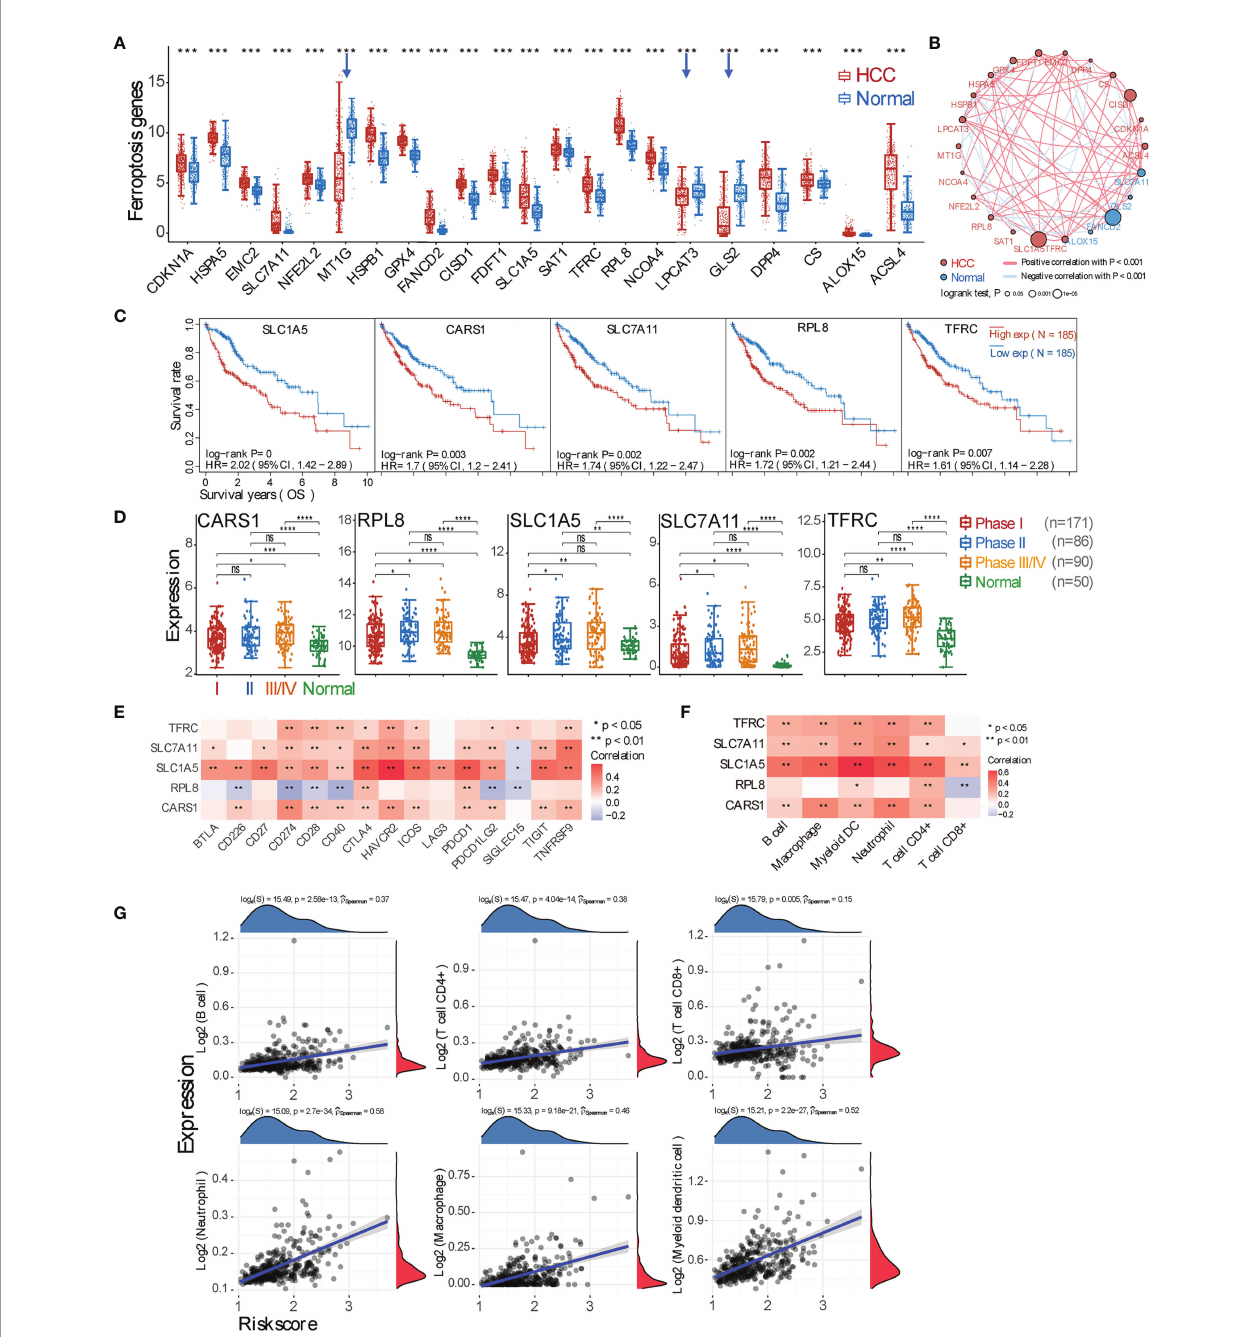
FIGURE 3 | Marker gene expression of ferroptosis and its correlation with tumor microenvironment (TME) immune pro fi le. (A) Expression comparison of ferroptosis marker genes between hepatocellular carcinoma (HCC) and normal tissues. The downregulated genes in HCC tissues are highlighted by blue arrows. (B) Gene relationship. Each circle represents a gene: the red one means positive, while the blue one represents negative correlation. The different sizes of the circle mean the different log-rank p-value. (C) Representative overall survival curves of 5 genes (SLC1A5, CARS1, SLC7A11, RPL8, and TFRC) that are negatively and signi fi cantly correlated with prognosis (p < 0.01). (D) Expression of these 5 marker genes in tumor tissues from pTNM stage I, II, or III – IV patients. (E) Correlation analysis between 5 marker genes and checkpoint molecules. (F) Correlation between 5 marker genes and major types of immune cell in fi ltration. (G) Spearman ’ s correlation analysis between the risk score of the prognostic model (calculated from the 5 marker genes) and the immune score. The horizontal axis represents the risk score of the prognostic model; the vertical axis represents the immune score. The density curve (red) on the right represents the distribution trend of the immune score, and the dark-blue density curve on the top represents the distribution trend of the risk score. The p-value and correlation coef fi cient ( ^ pSpearman) are shown at the top of the respective graph. *p < 0.05; **p < 0.01; ***p < 0.001; ****p < 0.0001; ‘ - ’ , ns, no statistical signi fi